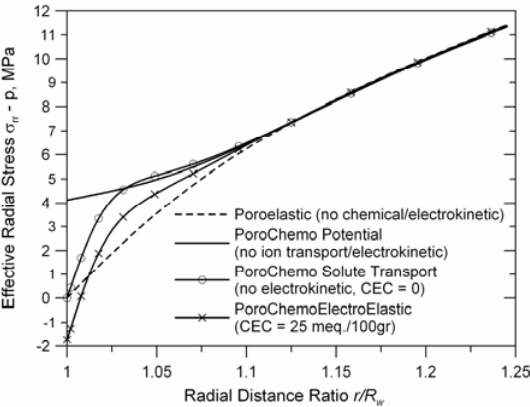
Fig. 9 – Pore pressure distribution in the formation after t = 15 minutes into drilling for low mud activity (high mud salinity): f . 87 < a f . 90. a o = 0 mud = 0